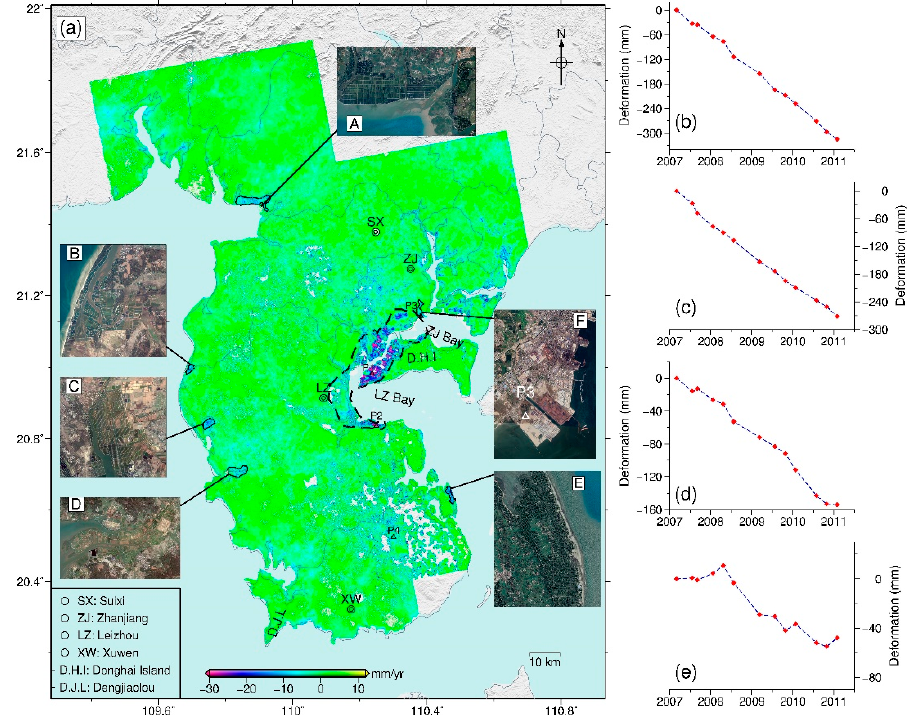
Figure 8. ( a ) Average surface deformation map of Leizhou Peninsula (LZP). Black solid circles are the selected subsidence bowls. Insets (A) to (F) are the corresponding optical images of the selected subsidence bowls. The black dotted circle represents the primary subsidence areas with a notable subsidence rate. P1 and P2 are two selected points located in aquaculture lands, P3 located in urban land, and P4 located in agricultural land. ( b – e ) are the corresponding time series of the four selected points.